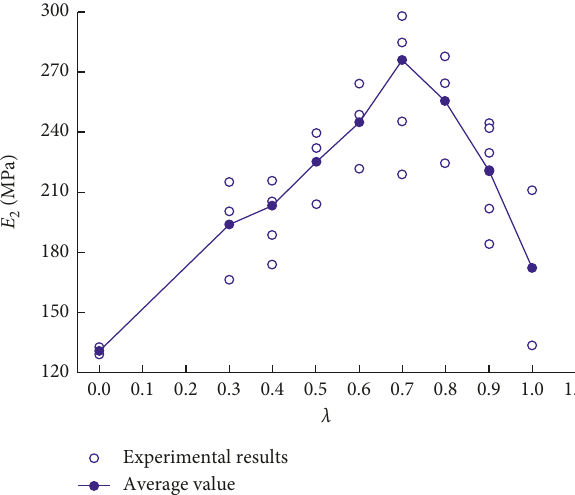
Figure 10: Variation in second-stage deformation modulus of artificial frozen silty clay with axial precompressive stress